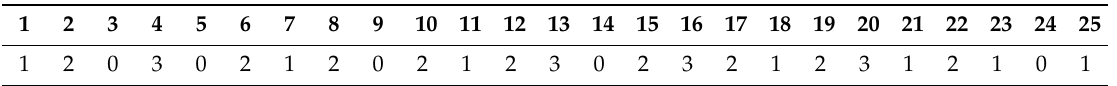
Table 4. Antibody coding.